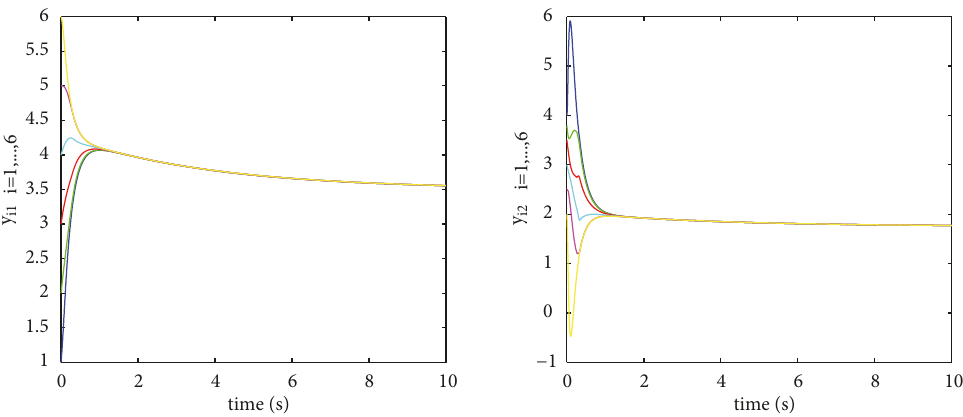
Figure 2: The state variables 𝑦(𝑡) under the edge-based algorithm.